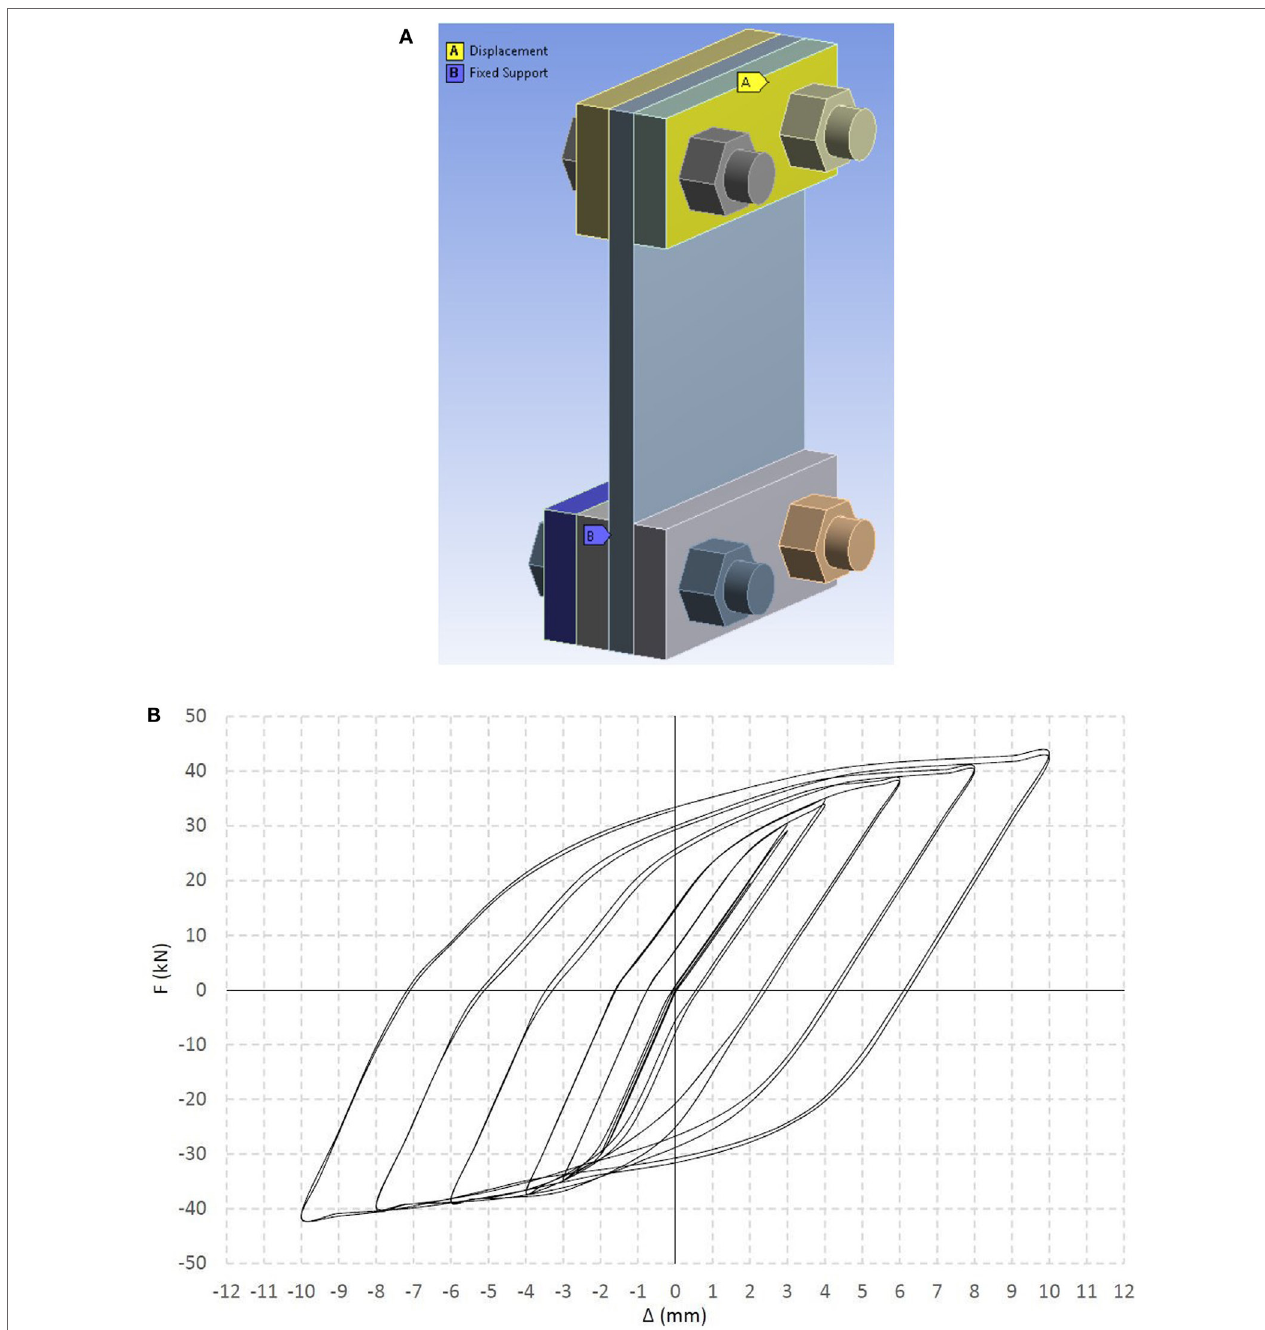
FiGUre 2 | Finite element model of beam-to-column connection with one straight dissipative plate: (A) geometry of finite element in ANSYS and (B) force–displacement curves.